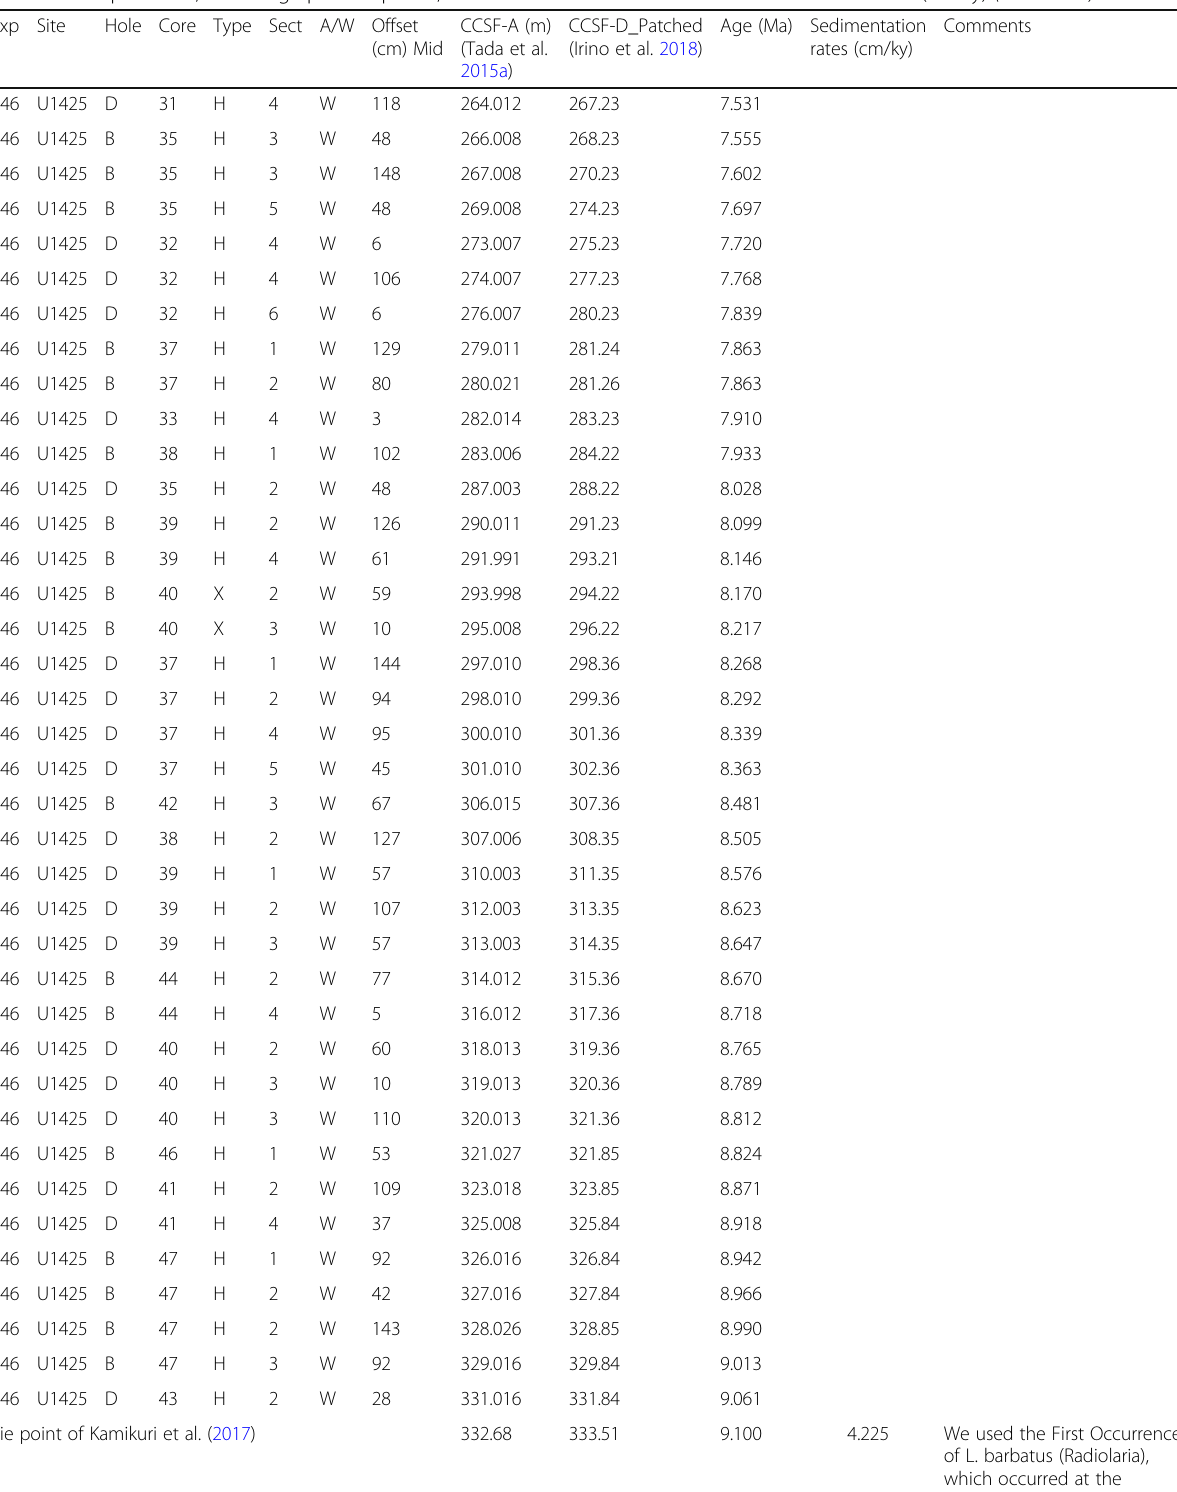
Table 1 Samples used, biostratigraphic tie points, and related sedimentation rates at IODP Site U1425 (cm/ky) (Continued) Exp